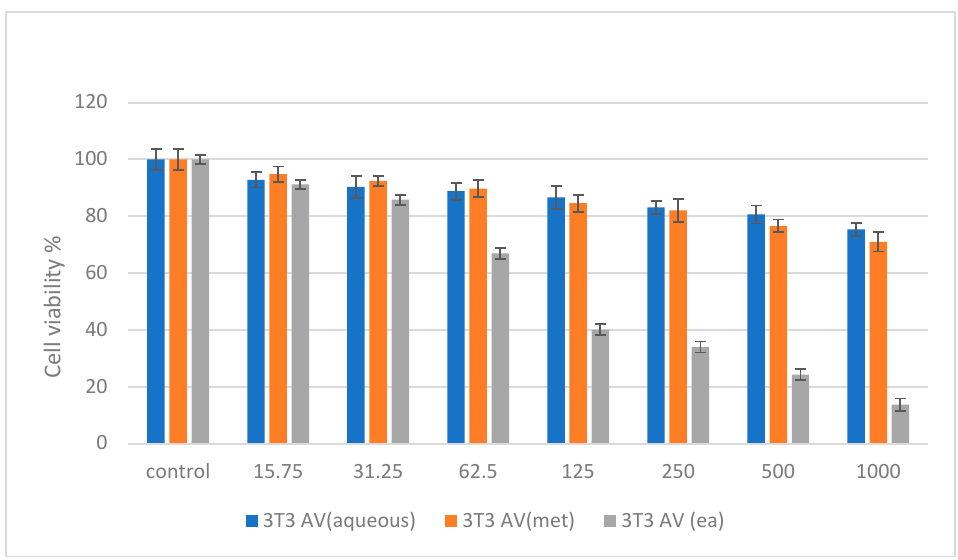
Figure 2. Cytotoxicity assay of Artemisia verlotiorum in aqueous, methanolic, and ethyl acetate extracts against normal 3T3 cells at 48 h.